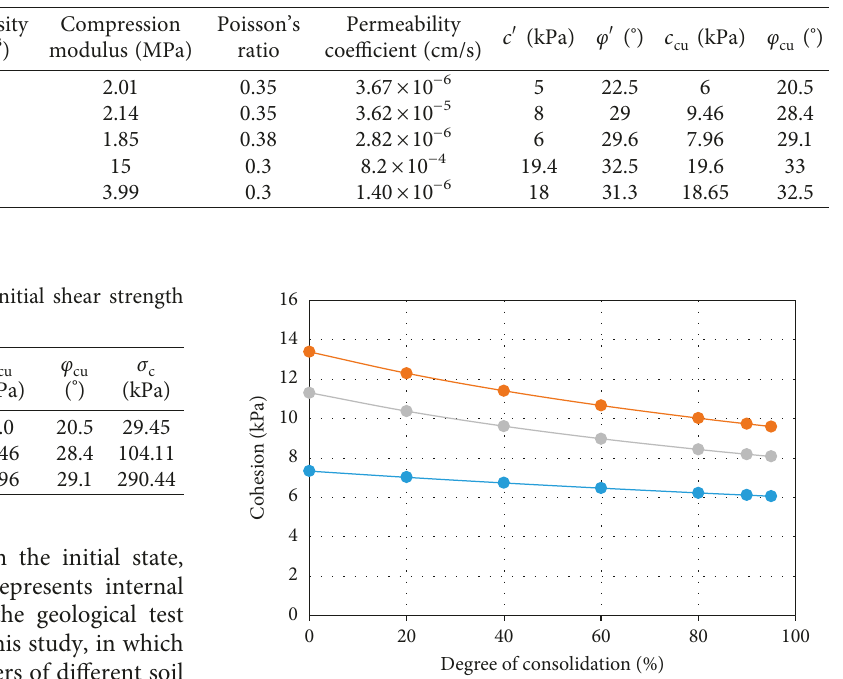
Figure 1: Application of vacuum preloading surcharge. Table 1: Stratification and physical and mechanical parameters of soil.